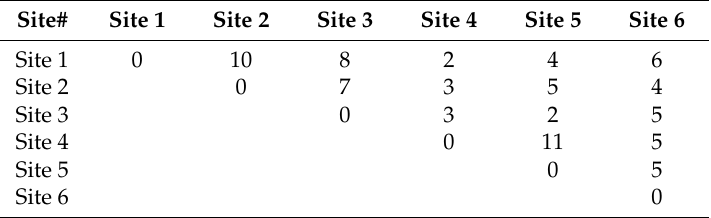
Table 1. Communication costs between sites